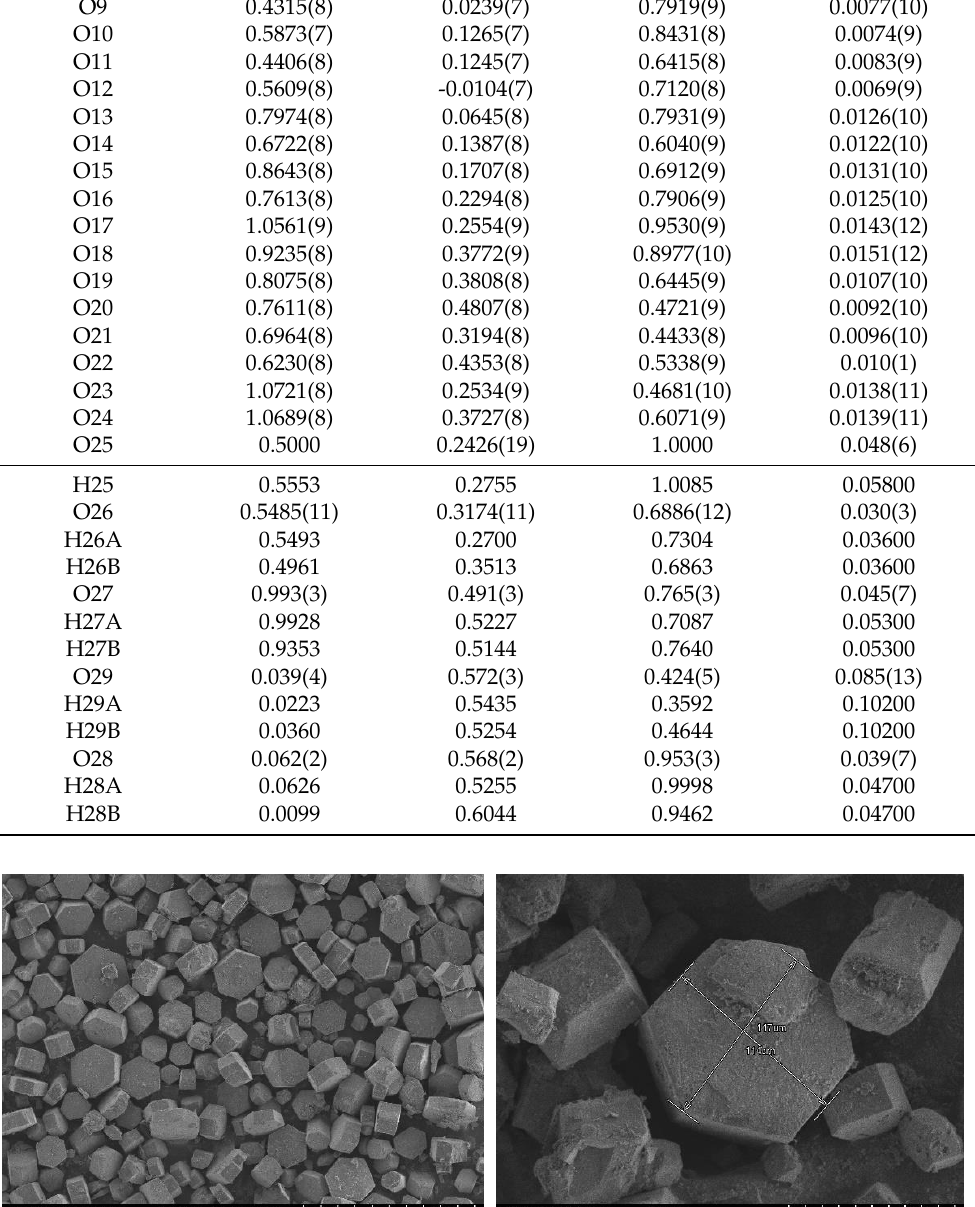
Figure 7. SEM images of the crystals prepared for single-crystal diffraction. Table 4. Coordinates of CaSO 4 ·0.5H 2 O from the single-crystal diffraction text.